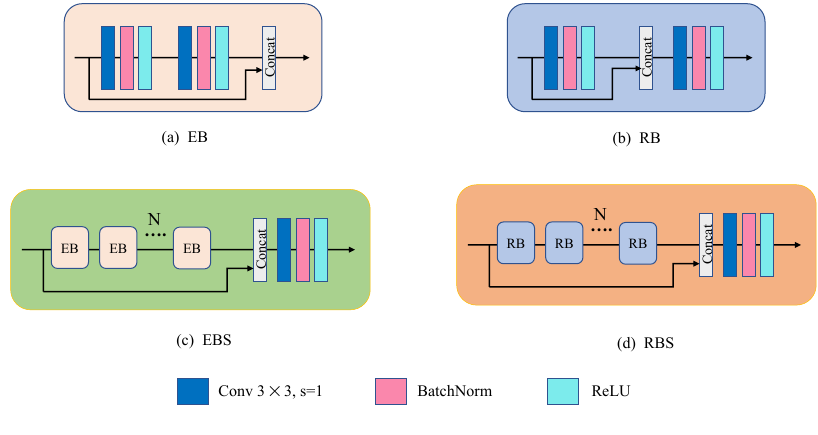
Figure 6. Architectures of ( a ) EB, ( b ) RB, ( c ) EBS, ( d )